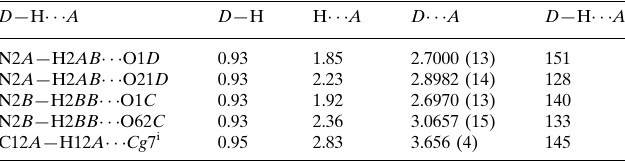
Hydrogen-bond geometry (A˚ , (cid:4) ).